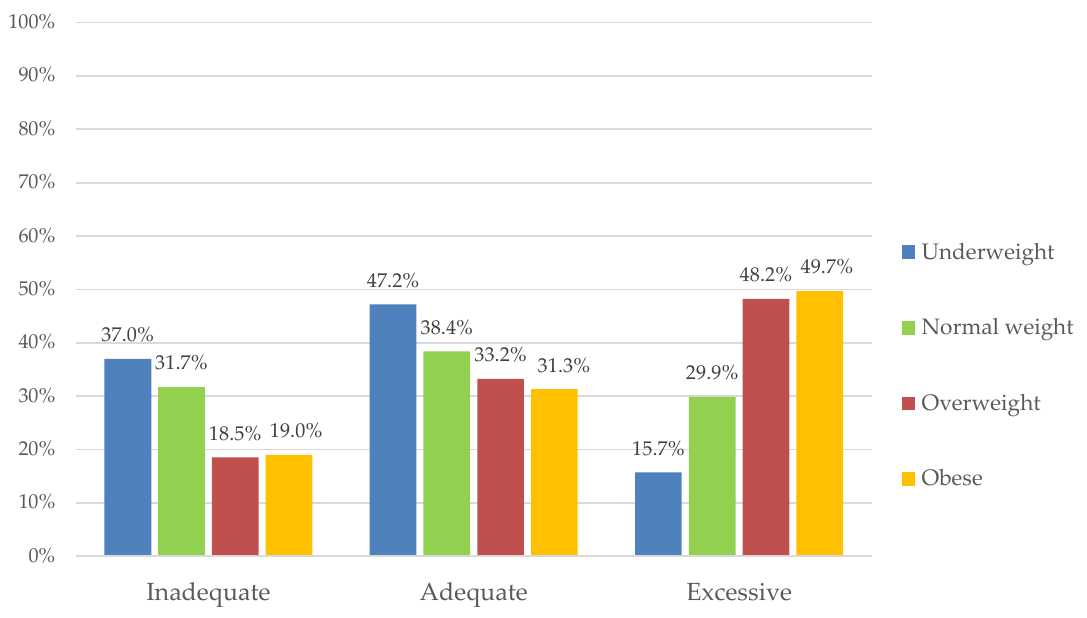
Figure 1. The proportion of maternal BMI categories in gestational weight gain groups (IOM recommendations). Legend: There is a significant difference between the distribution of overweight/obesity and underweight ( p < 0.001) and normal weight ( p < 0.001) in the inadequate gestational weight gain (GWG) group. In the adequate GWG group, there is a significant difference in the distribution of underweight compared to normal weight ( p < 0.001), overweight ( p < 0.001), and obesity ( p < 0.001). In the excessive GWG group, significant differences are between the proportion of women in underweight and normal weight categories ( p < 0.001) and in the overweight and obese compared to underweight ( p < 0.001) and normal weight categories ( p < 0.001).